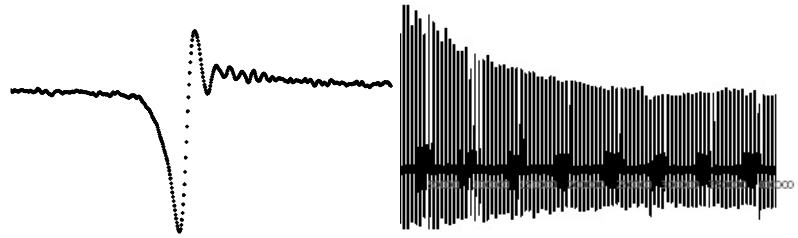
Figure 21. Example data to show how relaxation measurements can be obtained using low cost microcontroller capture.